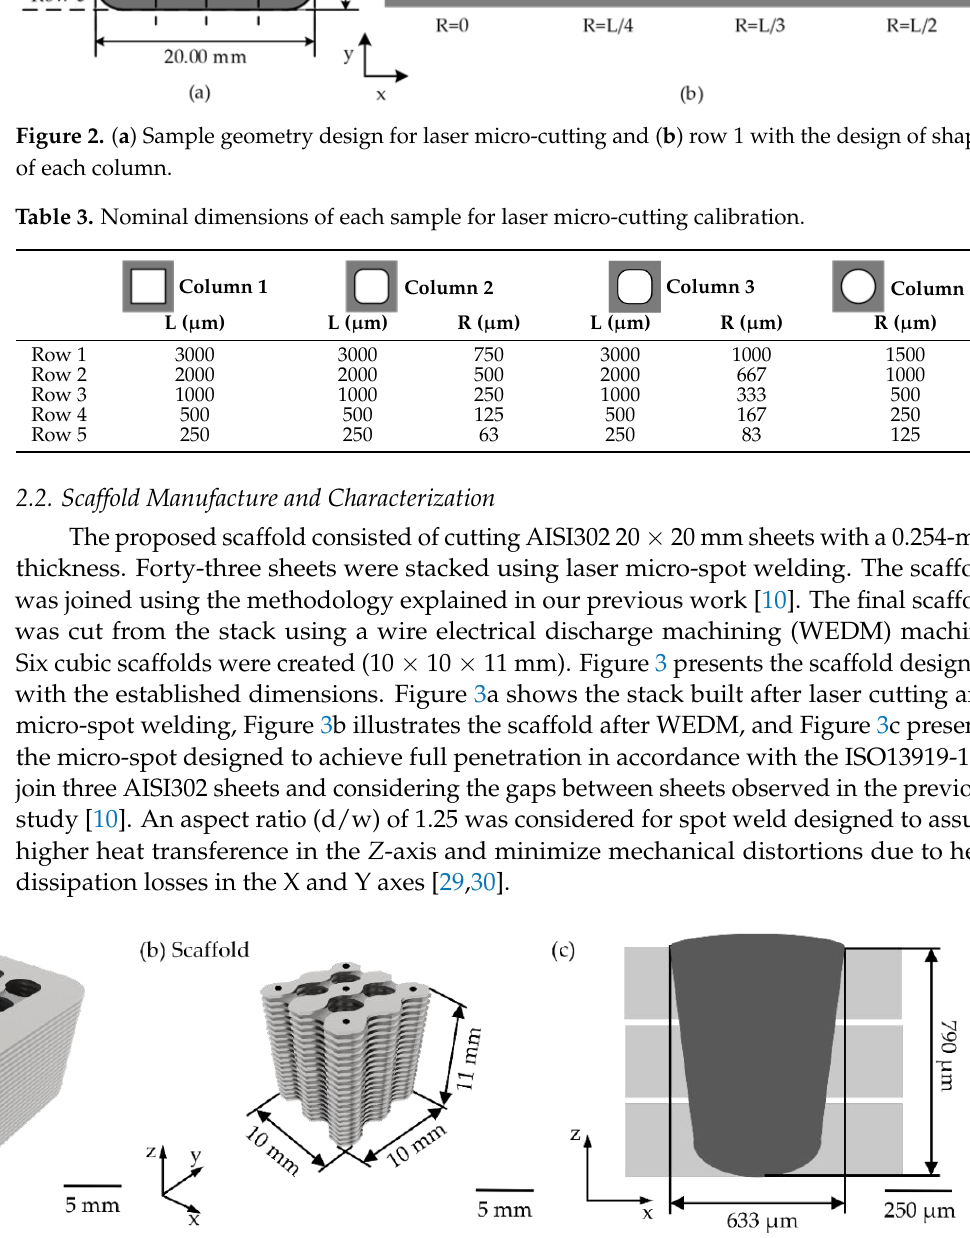
Figure 3. Designed scaffold ( a ) stack, ( b ) scaffold, and ( c ) laser micro-spot weld design .